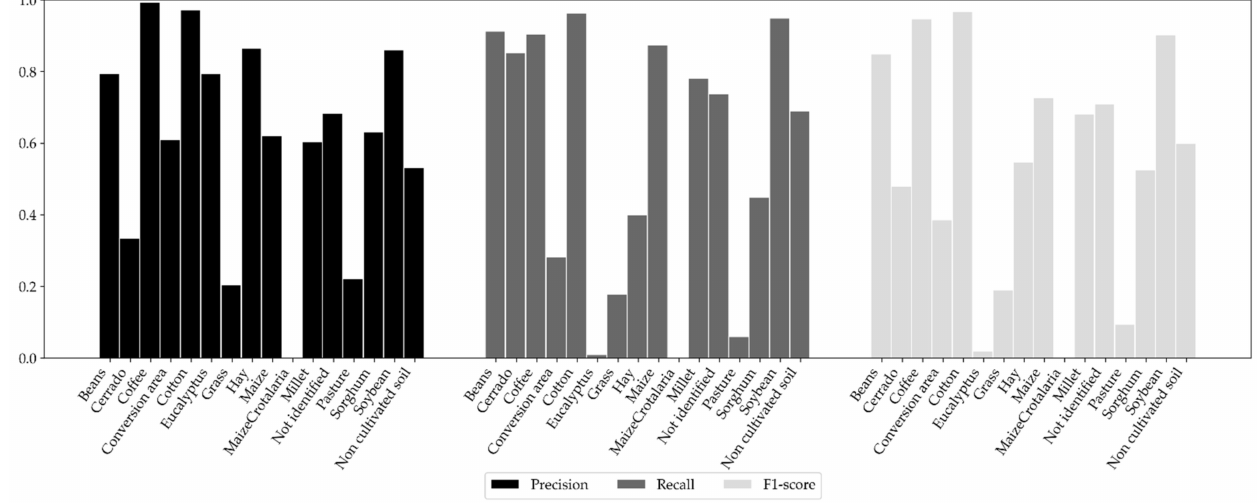
Figure 7. Precision, recall and F1-score for each class available in the MLP testing